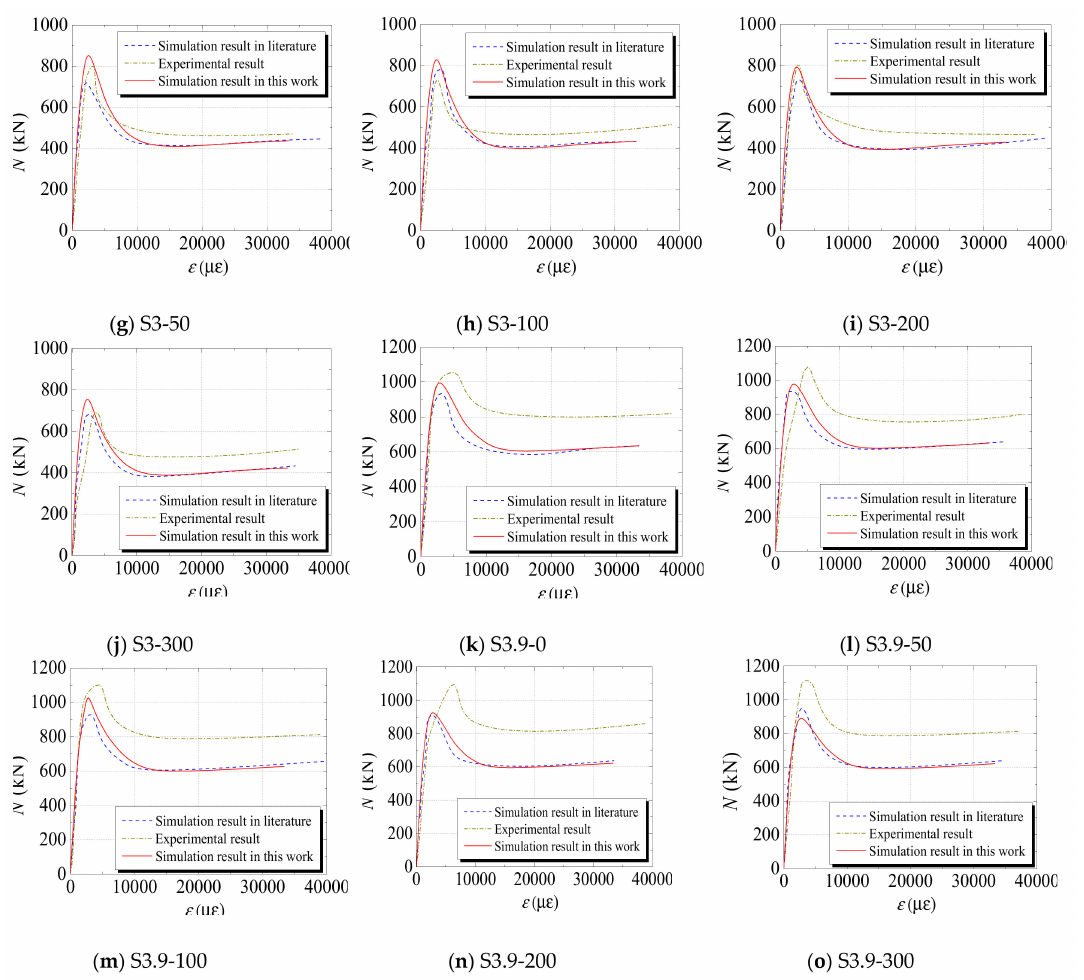
Figure 6. Comparisons between the numerical results in this study and the results (both experimental and numerical) in [35].